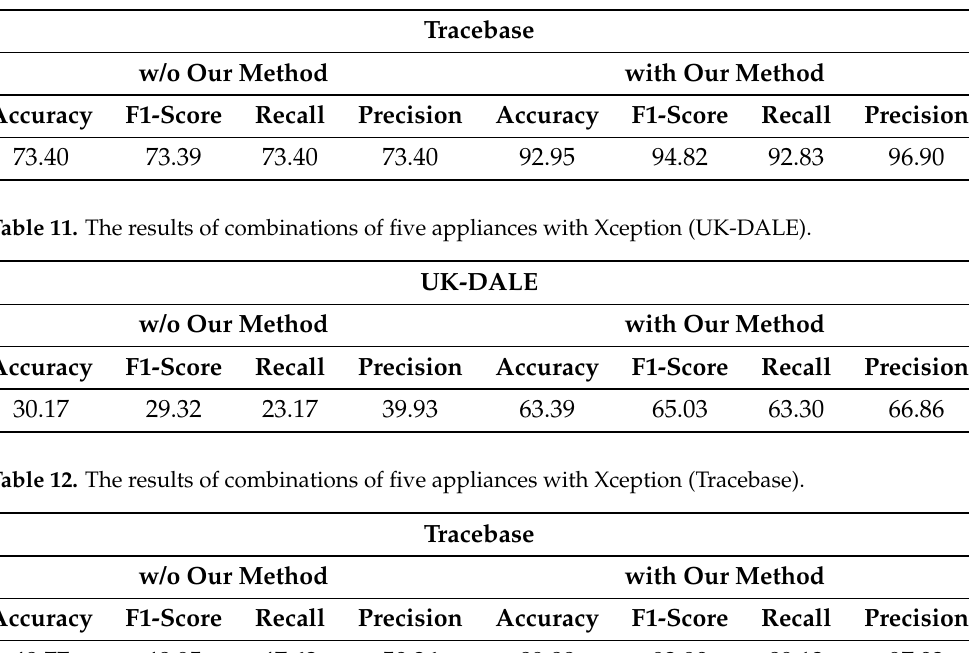
Table 10. The results of combinations of five appliances with VDOCNN (Tracebase).